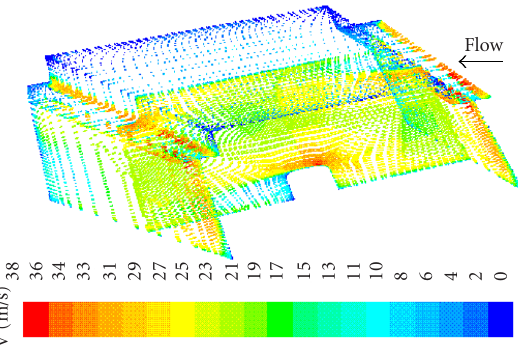
Figure 12: Representative velocity vectors around the ribs and on the channel center